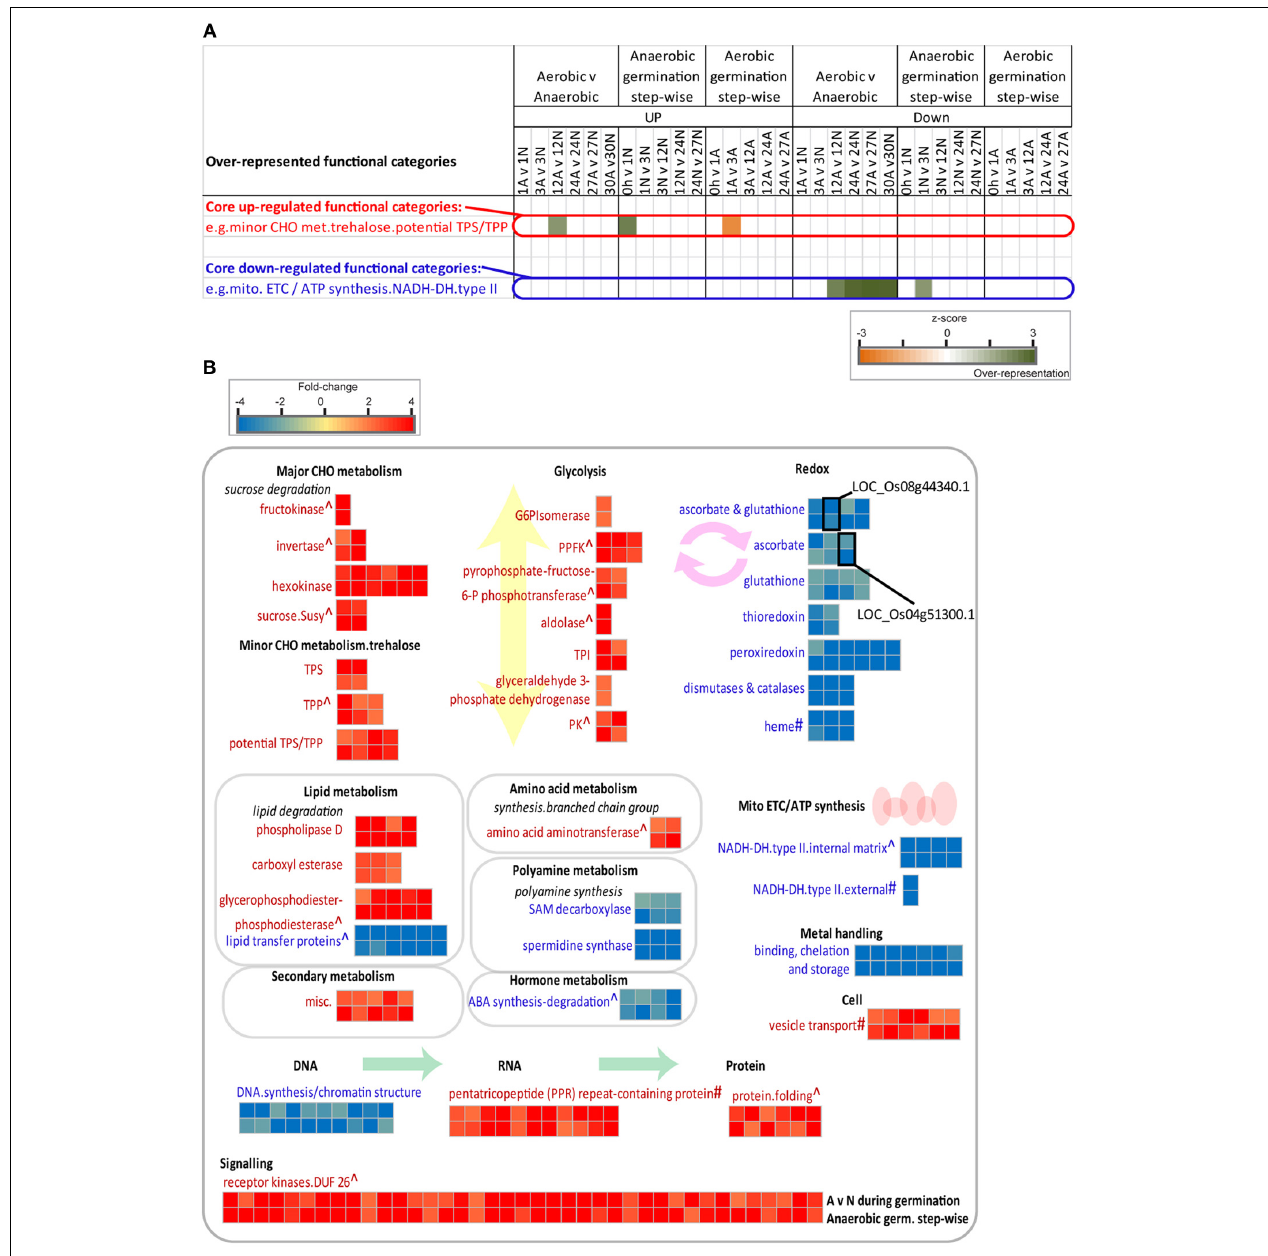
FIGURE 2 | Transcriptomic changes specific to anaerobic germination in rice. (A) Core up/down-regulated genes exclusive to anaerobic germination were identified by isolating genes encoding functions that were over-represented in comparison to aerobic germination (Aerobic v Anaerobic), as well as over the course of anaerobic germination (step-wise), whilst not being over-represented over the course of aerobic germination (step-wise). (B) Differential expression of genes encoding core over-represented functions unique to anaerobic